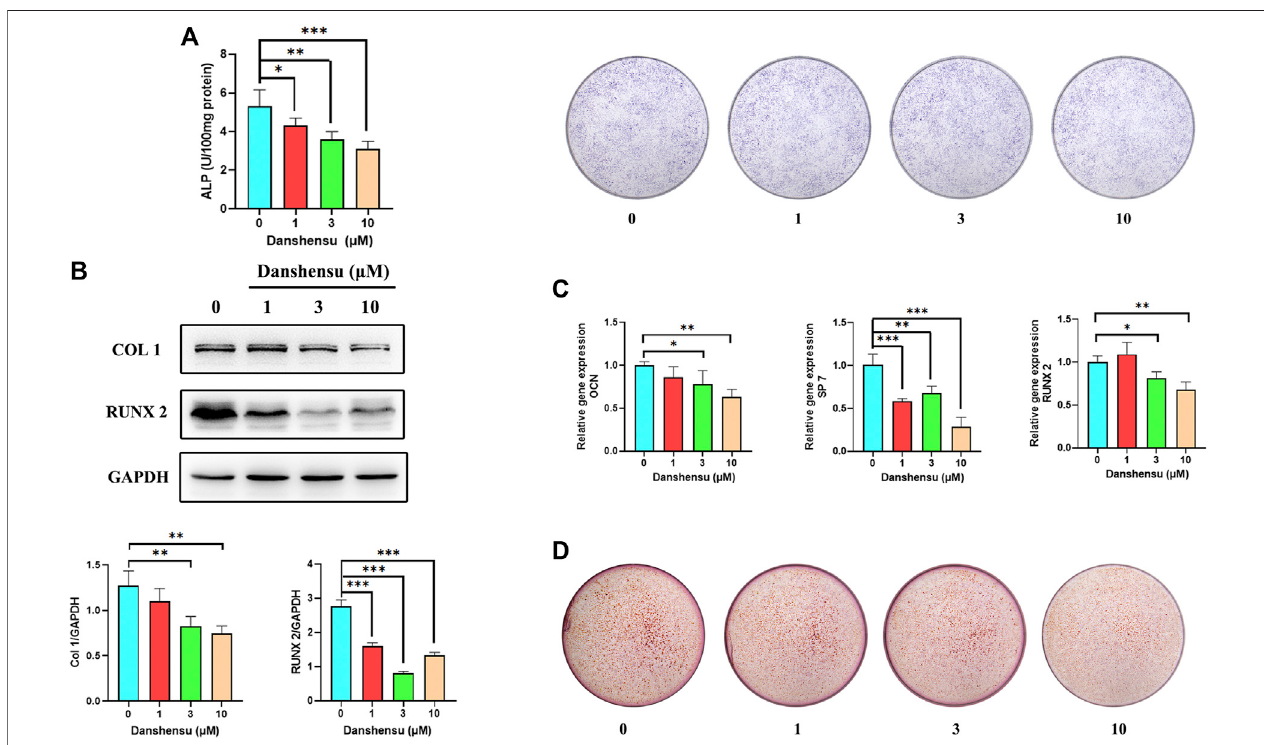
FIGURE9| Danshensusuppresses theossi fi cationofAS fi broblasts. (A) ALP activity andstainingofAS fi broblasts treatedfor7 dayswithdifferentconcentrations ofDanshensu. (B) RUNX2 andCOL1proteinlevelsonday14. (C) SP7,OCN,and RUNX2mRNAexpressionin fi broblastsonday14. (D) ARSofosteoblastsonday30.